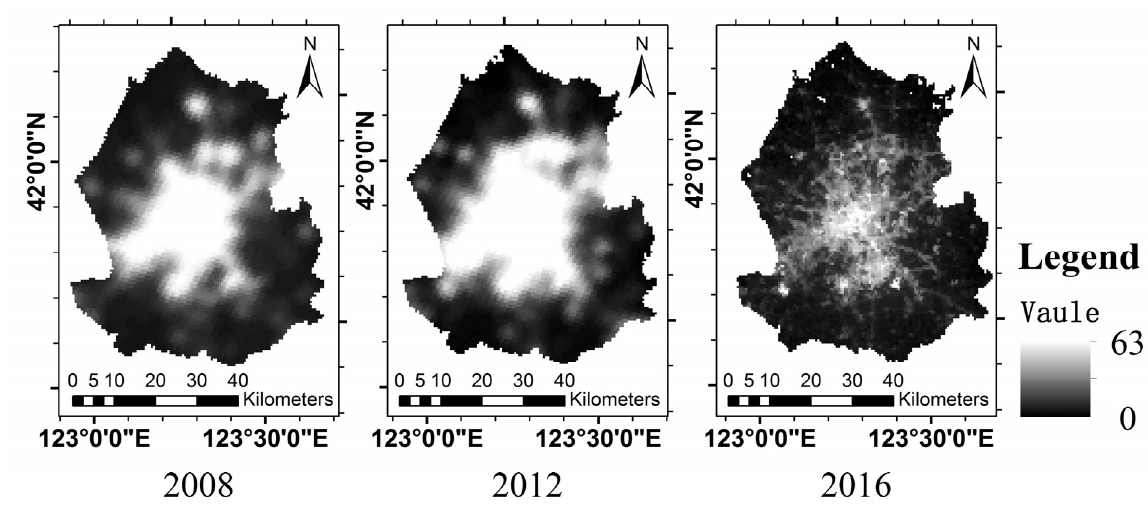
Figure 4. Shenyang night-time lighting images after radiation correction.